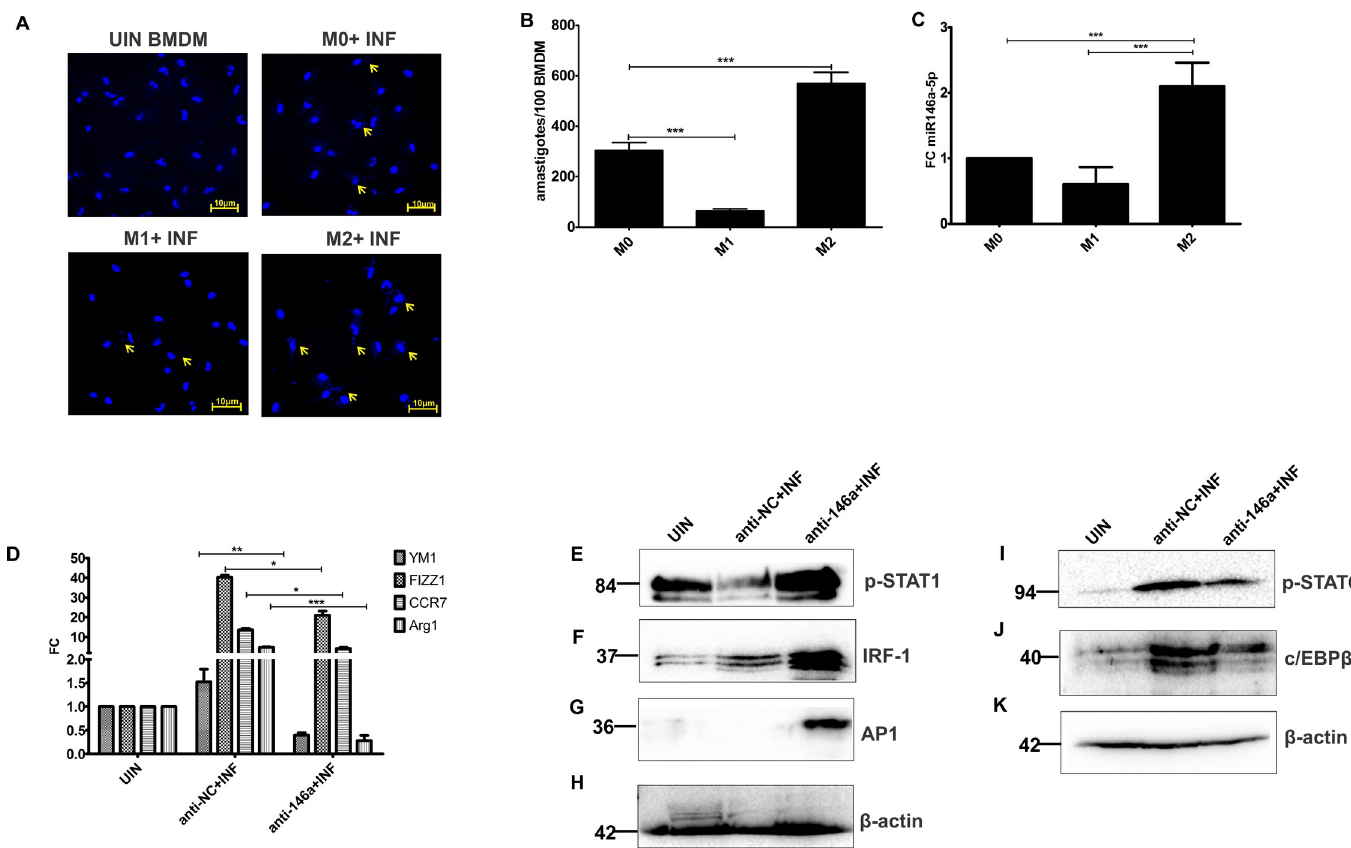
Fig 2. miR146a-5p is crucial for inducing M2 polarization and depleting M1 polarization markers in L . donovani infected BMDMs. Naive (M0), M1 and M2 polarized BMDMs were challenged with L . donovani at 1:10 MOI for 24 hrs, and infectivity index was determined by (A) confocal micrograph of Hoescht stained BMDMs (scale bar- 10 μ m) followed by (B) geimsa staining based calculation of amastigote burden per 100 BMDMs in 100X oil immersion microscope. (C) Expression of miR146a-5p was determined in M0, M1 and M2 polarized BMDMs by RT-PCR. Data represented as mean ± SD. (D) Expression of M2 polarization markers were analyzed in L . donovani infected BMDMs previously transfected with either anti-NC or anti-146a oligos. Expression of transcription factors essential for directing either M1 (E-H) or M2 (I-K) polarization of macrophages, were determined in anti-NC or anti-146a transfected and L . donovani infected BMDMs by western blotting, where β - actin served as loading control. Statistical significance ( � P < 0.05, �� P < 0.01, ��� P < 0.001) was calculated using one-way ANOVA and data are represented as mean ± SD (Graph pad prism 5.0).